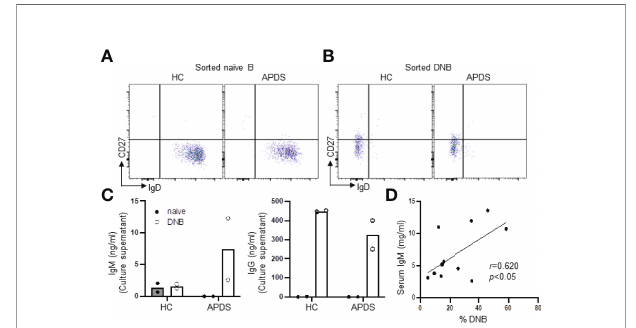
FIGURE 5 | DNB cells from a patient with APDS produced both IgM and IgG upon stimulation. Naïve B and DNB cells were sorted from PBMC of a HC and a PIK3CD patient (P13) and cultured in the presence of R848, BAFF, IL-21, IL-2 and IFN- g for 4 days. IgM and IgG levels in the culture supernatants were then measured by ELISA. (A and B) FACS pro fi les of sorted naïve (A) and DNB (B) cells. (C) Levels of IgM (left) and IgG (right) Abs in the culture supernatants of naïve B vs. DNB cells from a HC and a patient. Data from duplicate wells are shown. (D) Spearman ’ s correlation analysis revealed a strong association between the percentage of DNB cells and serum IgM levels in APDS patients (n=11). Spearman ’ s rank correlation coef fi cient r - and p -values are